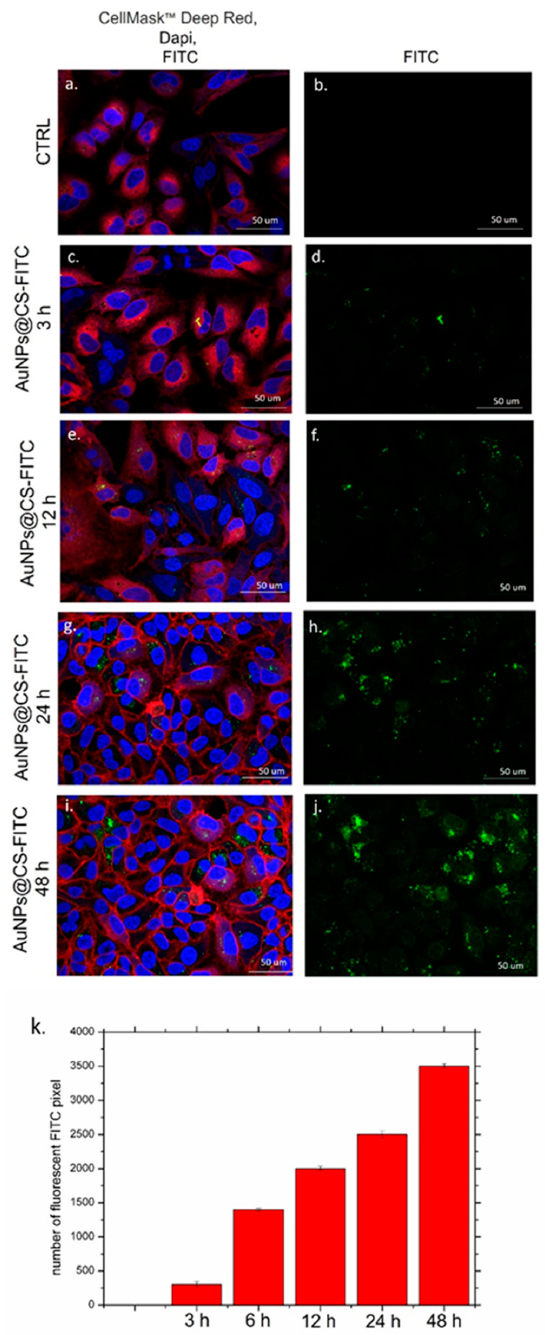
Figure 7. Confocal acquisitions of HeLa cells labeled by cellMask and Dapi to visualize actin (red) and nuclei (blue) ( a , c , e , g , i ) and relative green fluorescent ( b , d , f , h , j ) related to the internalization of AuNPs@CS-FITC in the time (0, 3, 6, 12, 24, 48 h). Fluorescence analysis conducted on confocal acquisitions using ImageJ software ( k ).